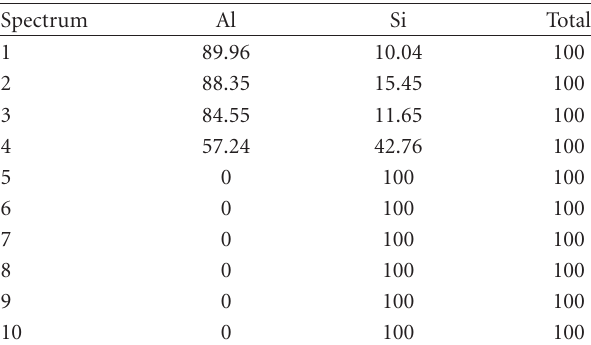
Table 1: EDX profile fired Al on the Si